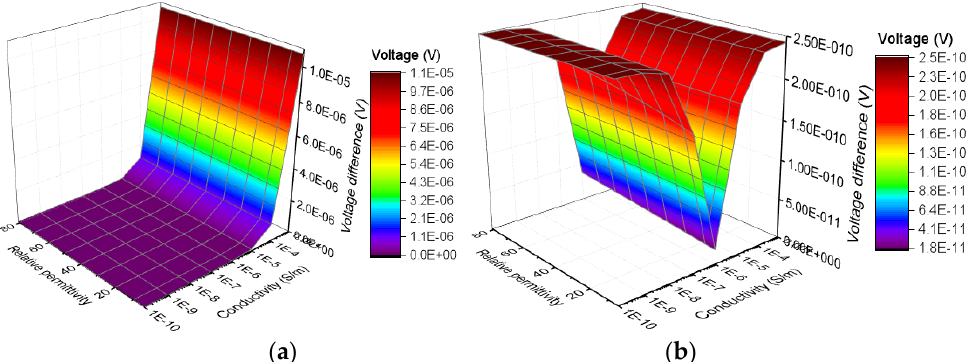
Figure 11. Change of voltage difference between adjacent electrodes with electrical parameters of surface layer of sheath: ( a ) Voltage difference between outer ring electrode and middle ring electrode; ( b ) Voltage difference between inner ring electrode and middle ring electrode.